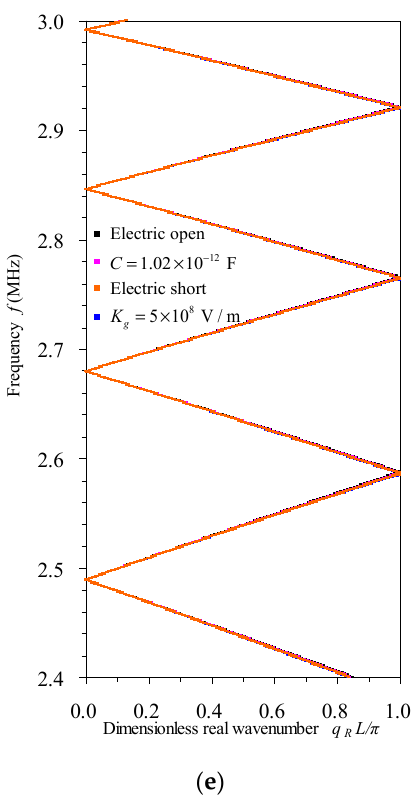
Figure 3. The phase constant spectra of the homogeneous PZT-5H piezoelectric rod with periodic electrical boundaries: ( a ) electric-open condition; ( b ) applied electric capacity condition with C “ α A { l “ 1.02 ˆ 10 ´ 12 F; ( c ) electric-short condition; ( d ) applied feedback control condition with K g “ 5 ˆ 10 8 V { m; and ( e ) all of the four abovementioned conditions in high frequency range.